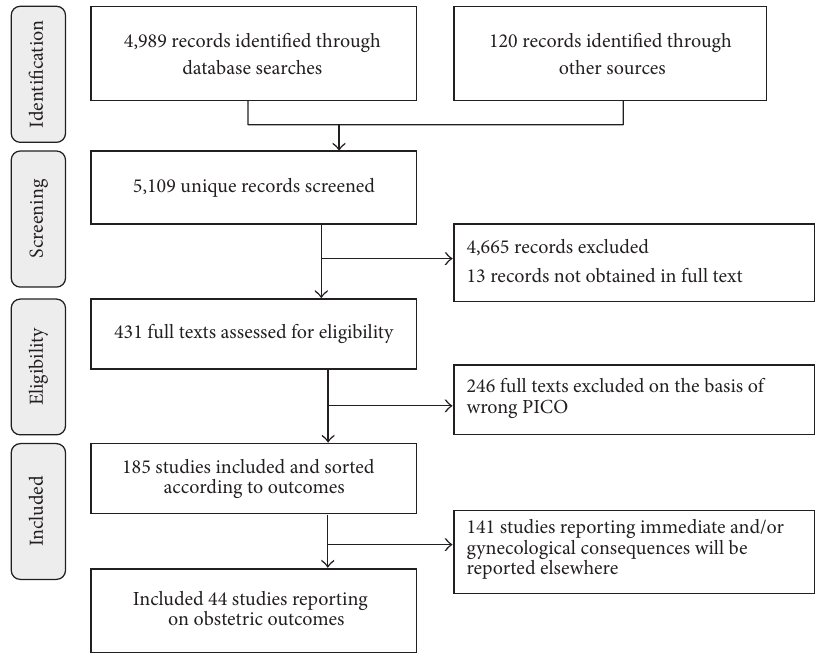
Figure 1: PRISMA flow diagram of the literature reviewing